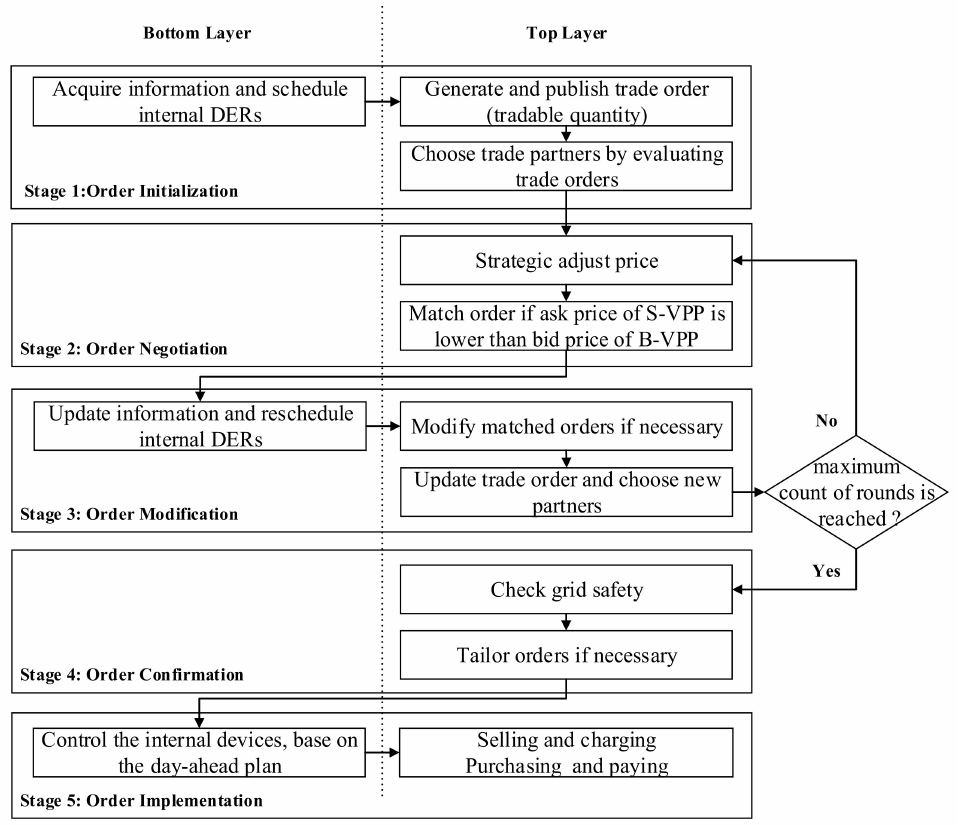
Figure 2. Five-stage trade order processing of P2P energy trading. VPP, virtual power plant; DER, distributed energy